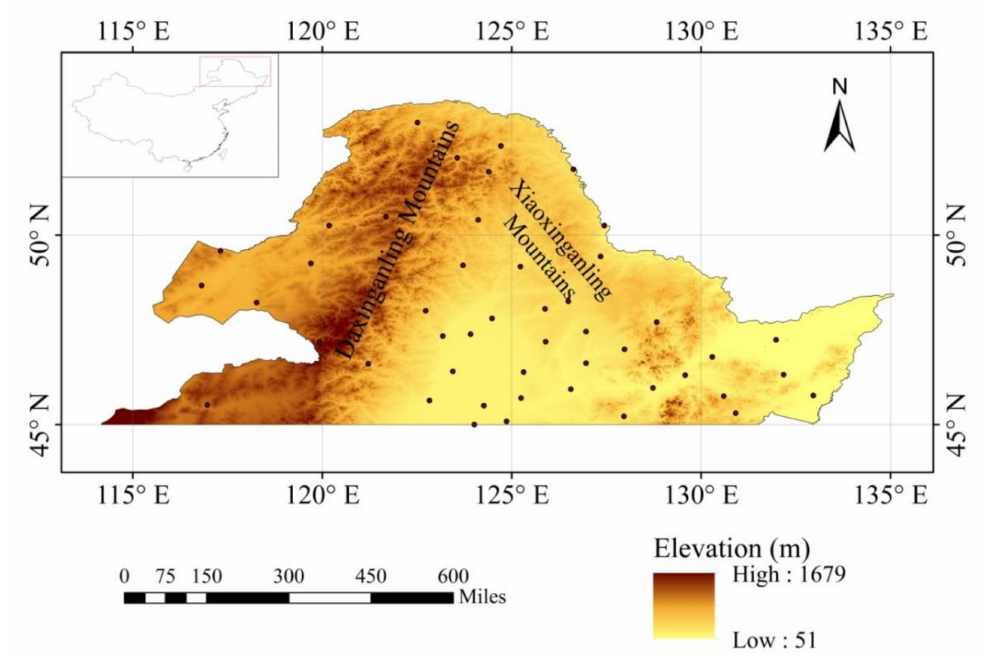
Figure 1. The distribution of 47 meteorological stations in Northeast